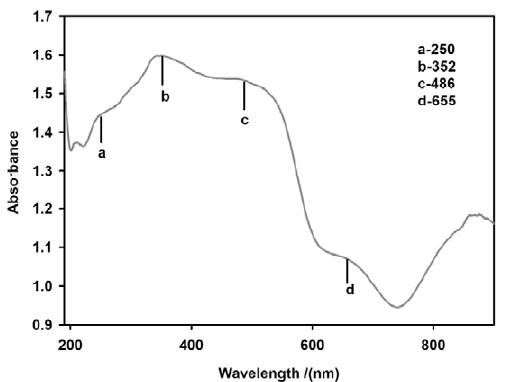
Fig.6.Tauc plot of iron oxide nanoparticles prepared by combination sol-gel auto-combustion with ultrasonic